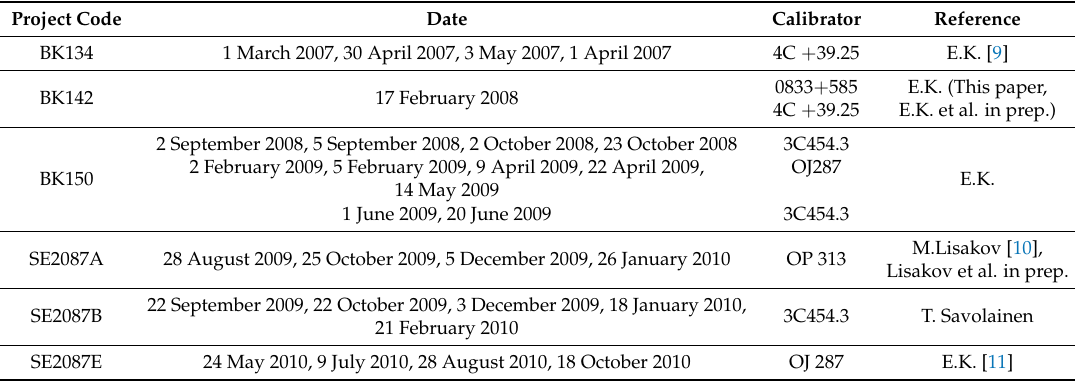
Table 1. The VLBA projects are used to connect D-term phases and